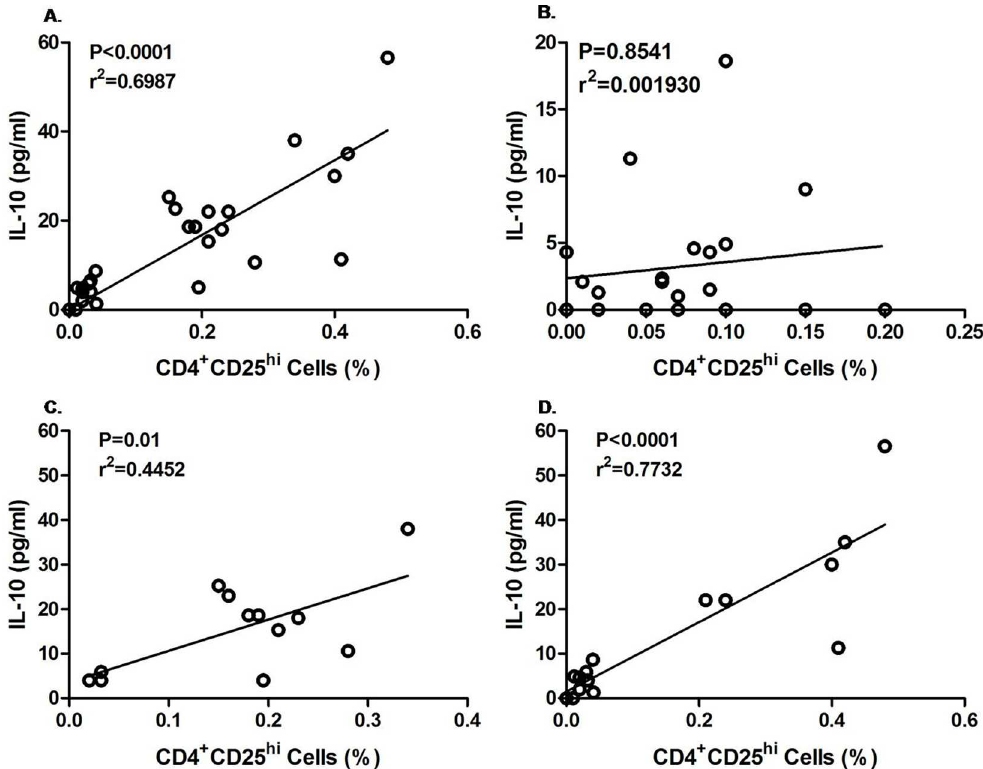
Fig 6. The relationship between regulatory Tregs (CD4+CD25 hi ) with IL-10 level of children born to mother who were CFA +ve and CFA–veat the time of enrolment. Each dot representsvalue from a single subject while the solid lines represent the regression lines. Valuesof p and r derive from Pearson’s correlationanalysis. (A) Childrenof enrolledCFA +ve mother (n = 28, p < 0.0001, r 2 = 0.6987) (B) childrenof enrolledCFA-ve mother (n = 21, p = 0.8541, r 2 = 0.001930).(C) CFA +ve childrenborn to enrolledCFA+ve mother (n = 12,p = 0.01, r 2 = 0.445) (D) CFA-ve childrenborn to enrolledCFA+ve mother (n = 16, p < 0.001,r 2 =